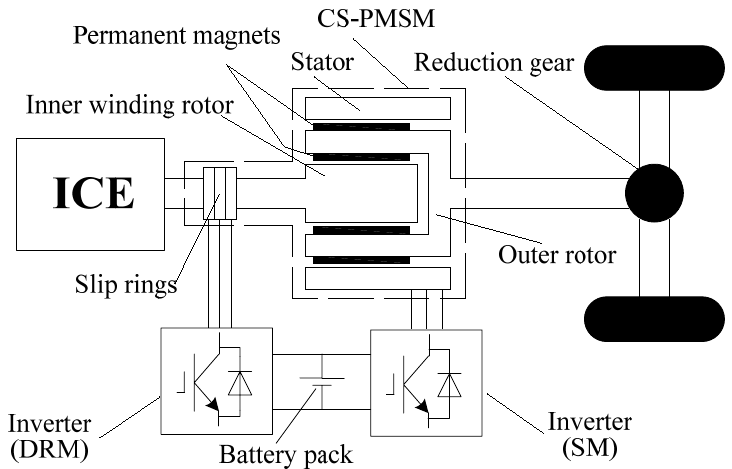
Figure 1. Schematic diagram of a hybrid electric drive system based on